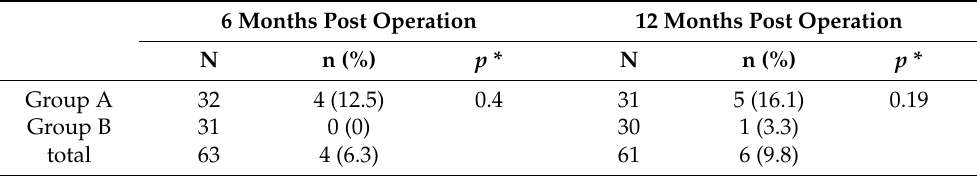
Table 5. The anatomic failure rate at the 6-month and 12-month follow-ups. 6 Months Post